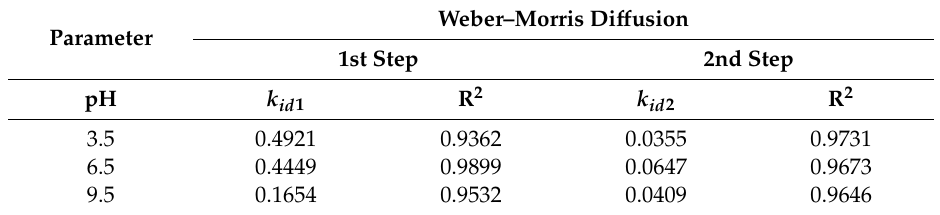
Table 4. Rate constants for the adsorption kinetic model of As(V) on NZVI / AC at di ff erent pH values.